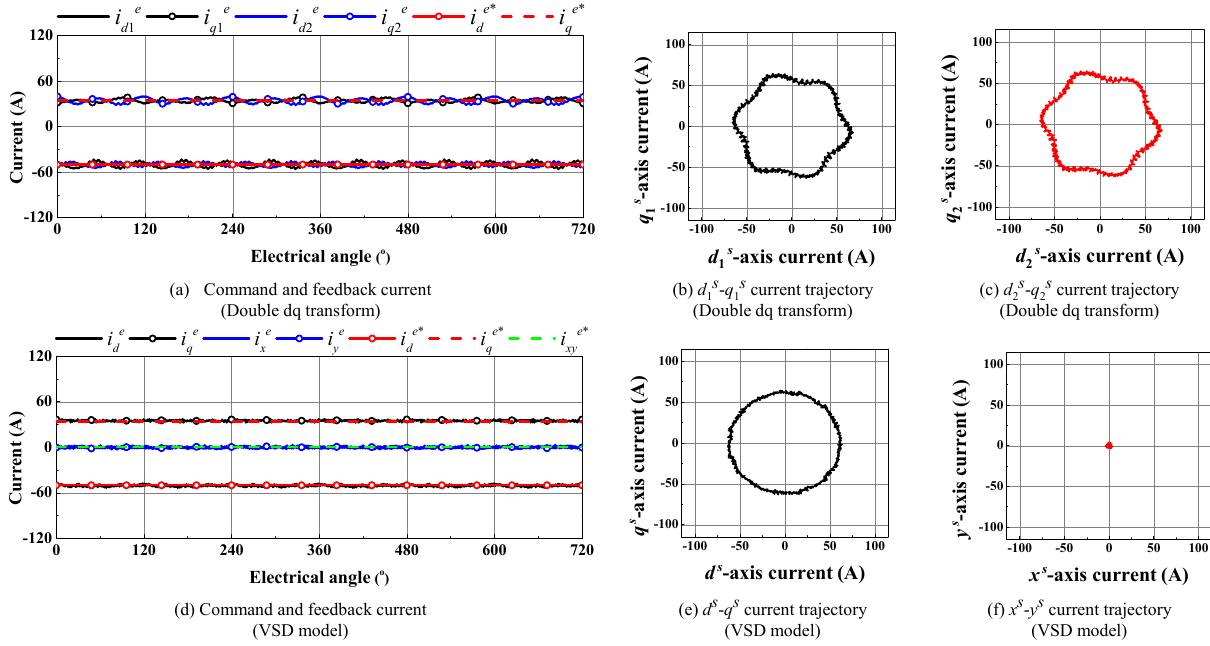
Figure 4. Simulation results of rotational coordinate command, feedback currents ( a , d ) and stational coordinate current trajectory ( b , c , e , f ) when applying to the Double dq transform and VSD model.